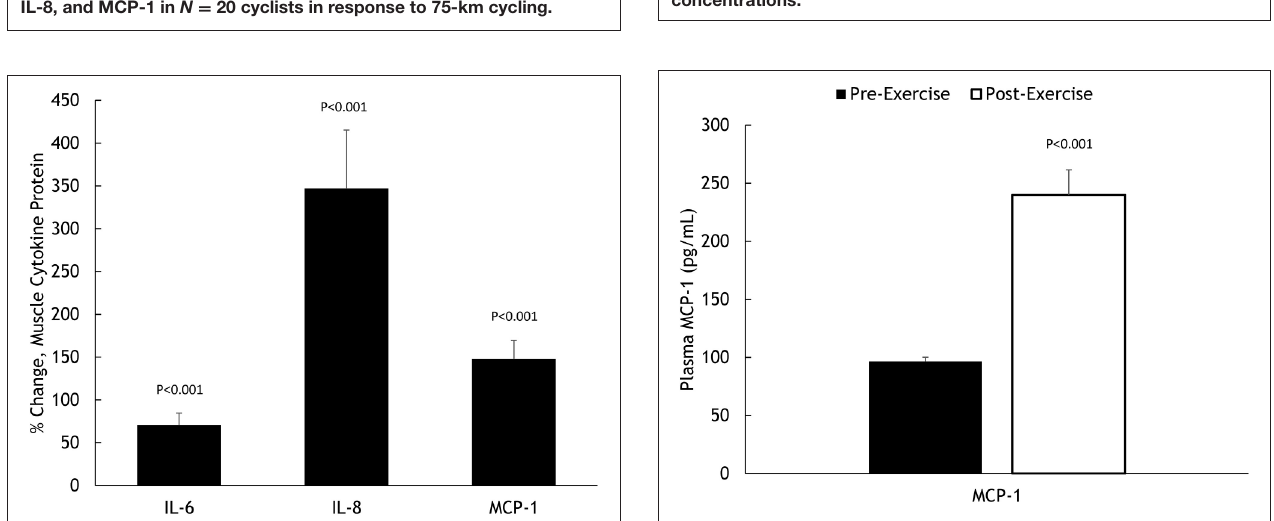
FIGURE 3 | Percent change in skeletal muscle cytokine protein content for IL-6, IL-8, and MCP-1.